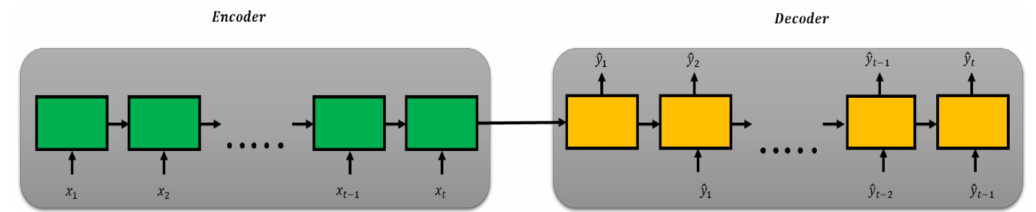
Figure 4. Encoder–decoder for sequence-to-sequence learning for time series